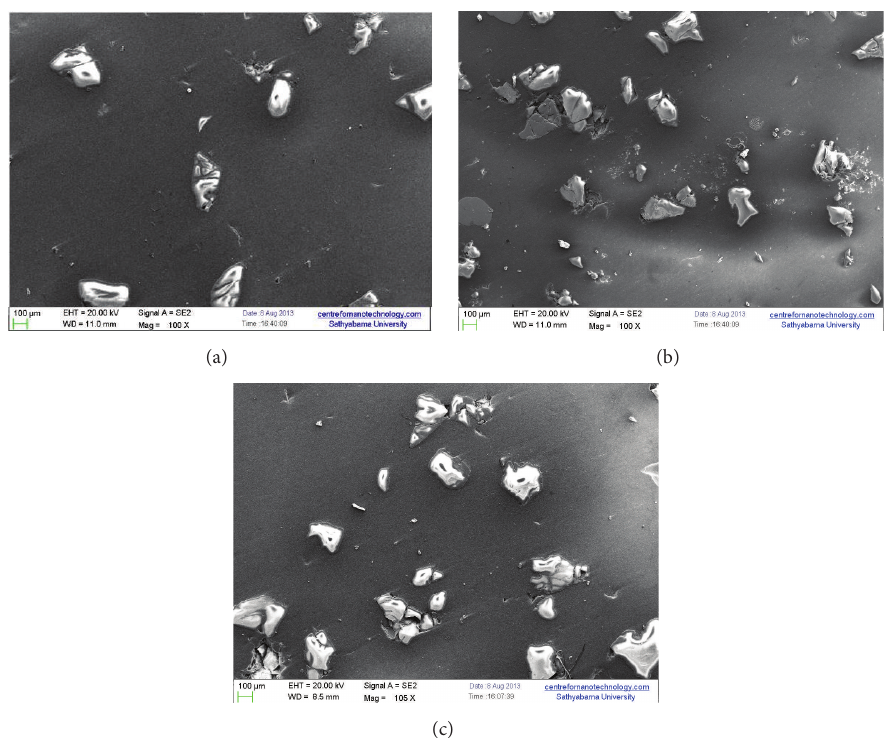
Figure 1: Dispersion of red mud (a) 3 wt.%, (b) 4 wt.%, and (c) 5 wt.%.